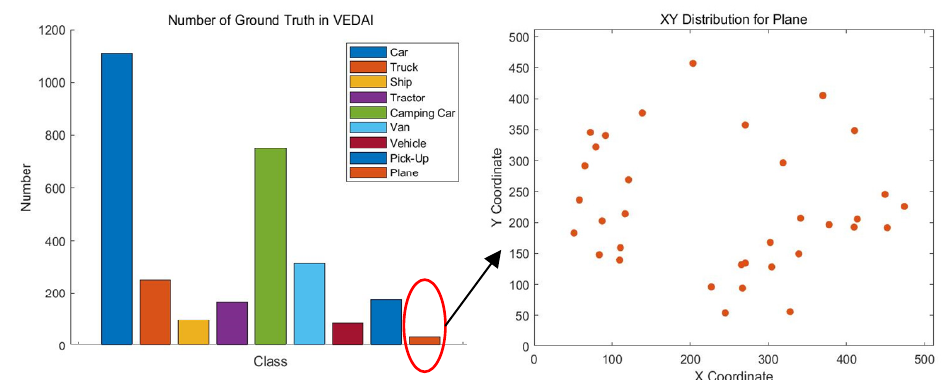
Figure 10. XY distribution for the Plane class in the VEDAI dataset.